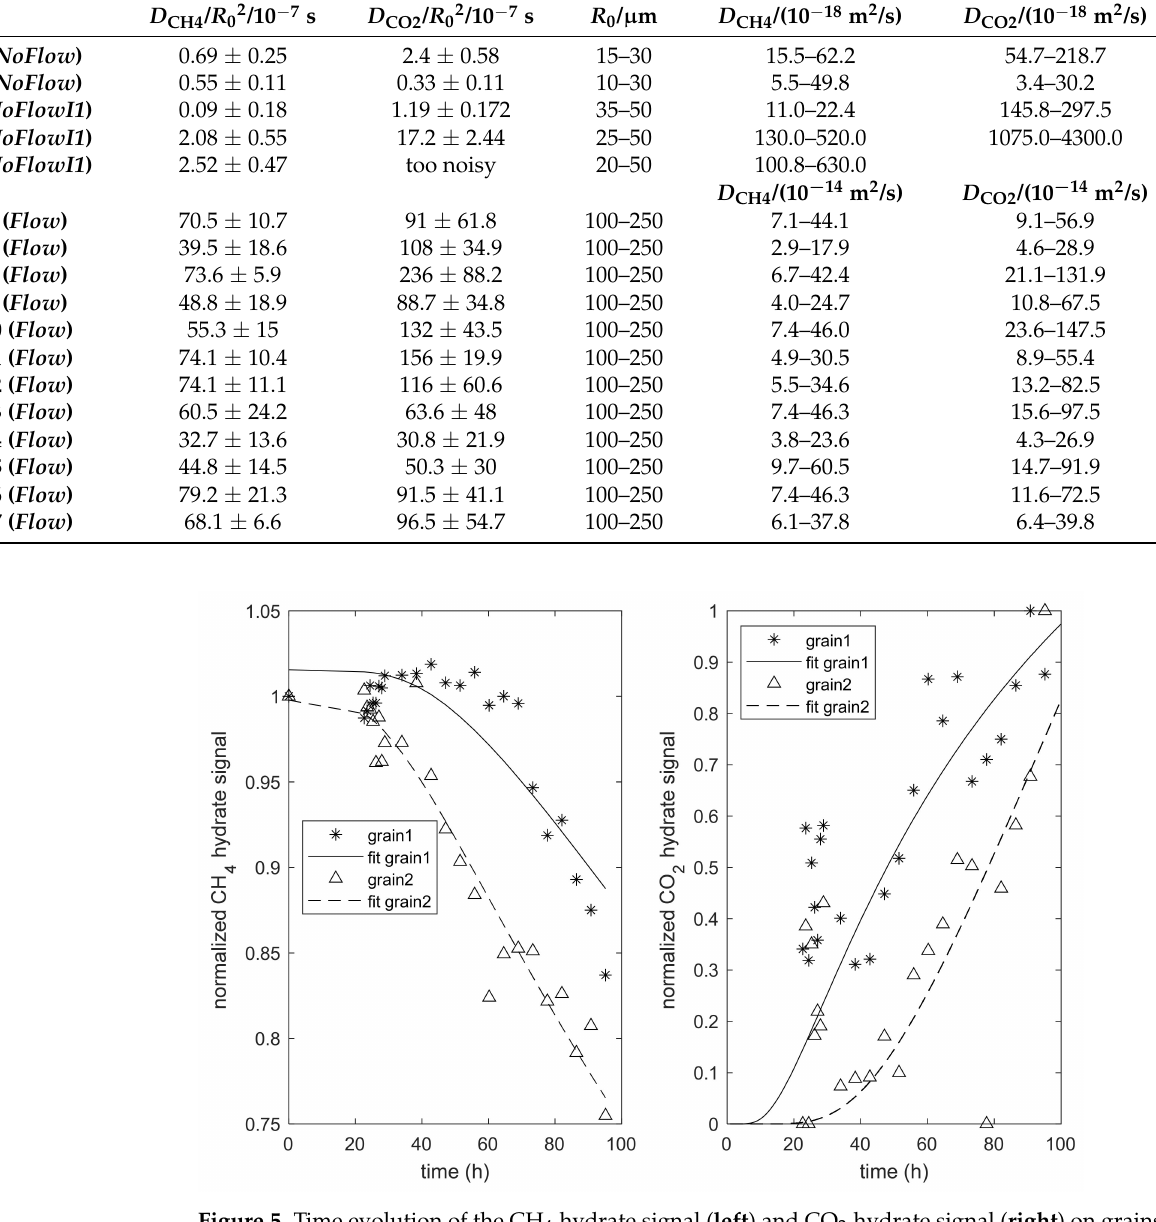
Figure 5. Time evolution of the CH 4 hydrate signal ( left ) and CO 2 hydrate signal ( right ) on grains 1 and 2 with regressed curves from the diffusion